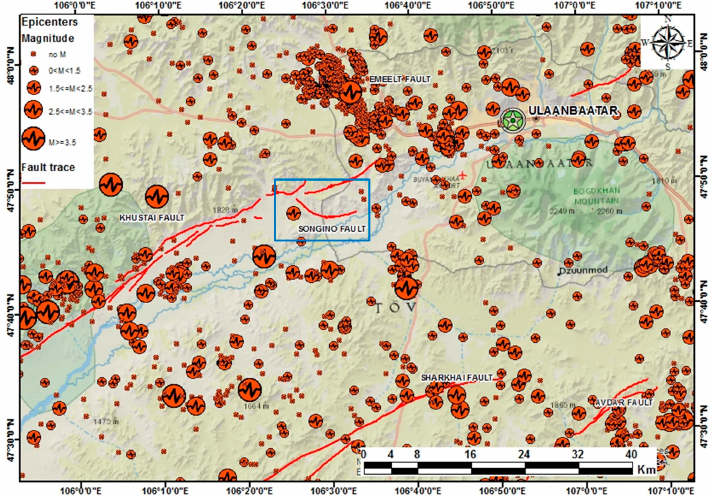
Figure 1. Seismicity map (orange symbols) around Ulaanbaatar city from 1994 to 2015 (NDC data, IAG, MAS). The green star indicates the UB city center. Red lines indicate the trace of main active faults. The Songino fault (blue rectangle) located between Emeelt and Khustai faults is about 20 km long and situated about 25 km SW of UB’s western end.